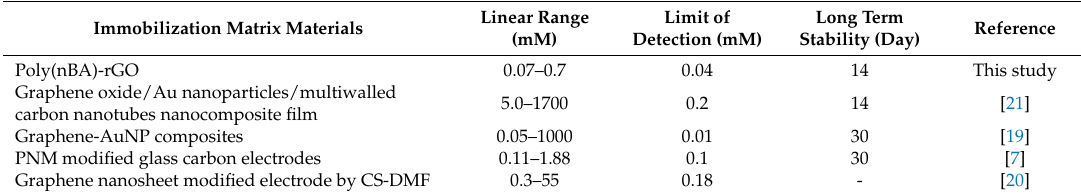
Table 3. A comparison of poly(nBA)-rGO/SPE based on electrochemical Hb biosensor with other previously reported studies on electrochemical Hb biosensor for nitrite